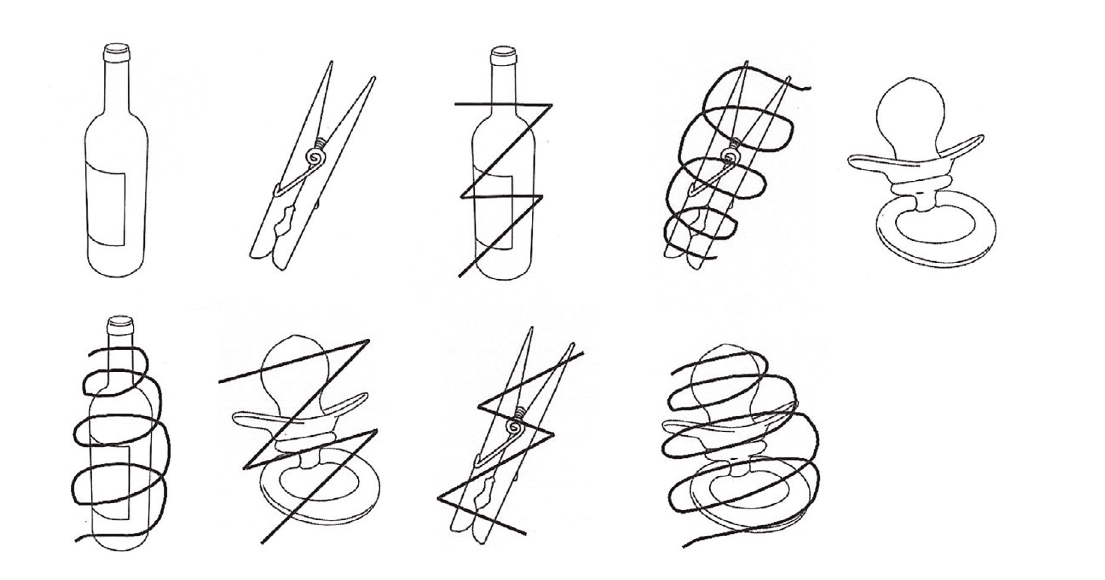
Fig. 1. Stimuli used in the visual­perception